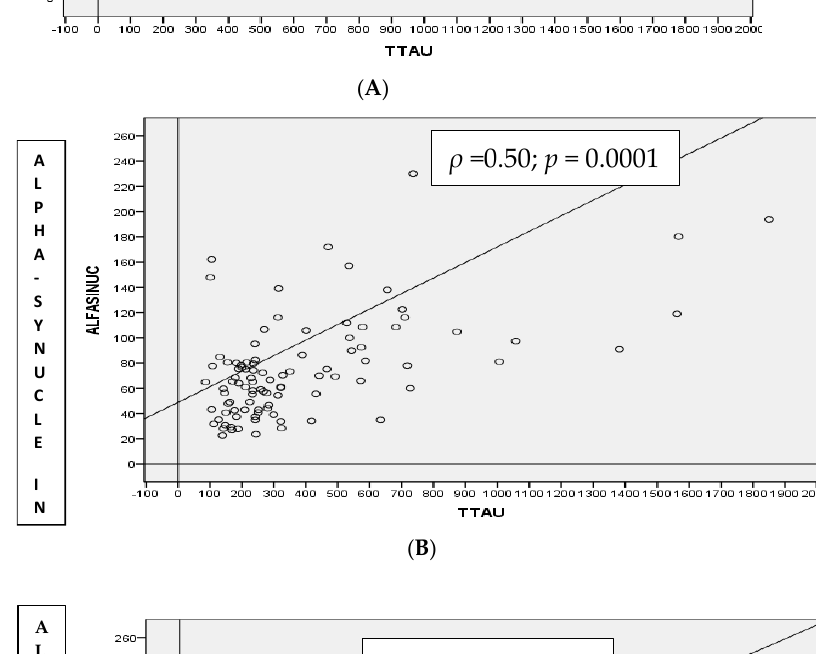
Taking the population as a whole, α-syn CSF levels were positively correlated with both T-tau ( ρ = 0.509, p -value < 0.01) and p-tau 181p ( ρ = 0.528, p -value < 0.01). As expected, there was a strong positive correlation between T-tau and p-tau 181p protein levels ( ρ = 0.882, p value < 0.01) and a slight negative correlation between Aβ 1–42 protein and T-tau ( ρ = −0.475, p -value < 0.01) and p-tau 181p ( ρ = −0.478, p -value < 0.01) (Figure 1). and p-tau 181p ( ρ = 0.29) were low and without statistical significance. No other significant correlations were found between the “core” biomarkers with either of the α -syn CSF levels.